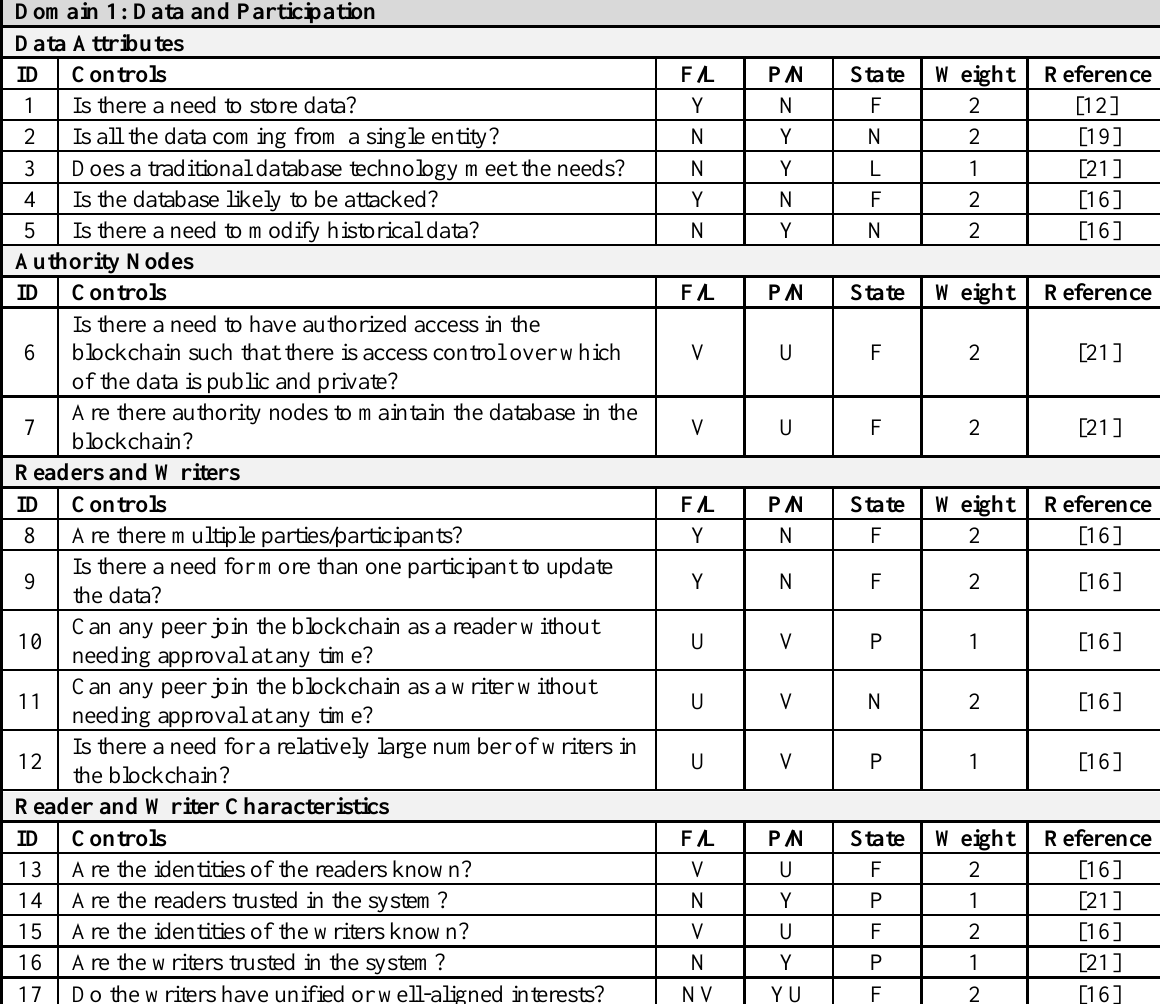
Table 2. Domain 1 of the blockchain applicability framework